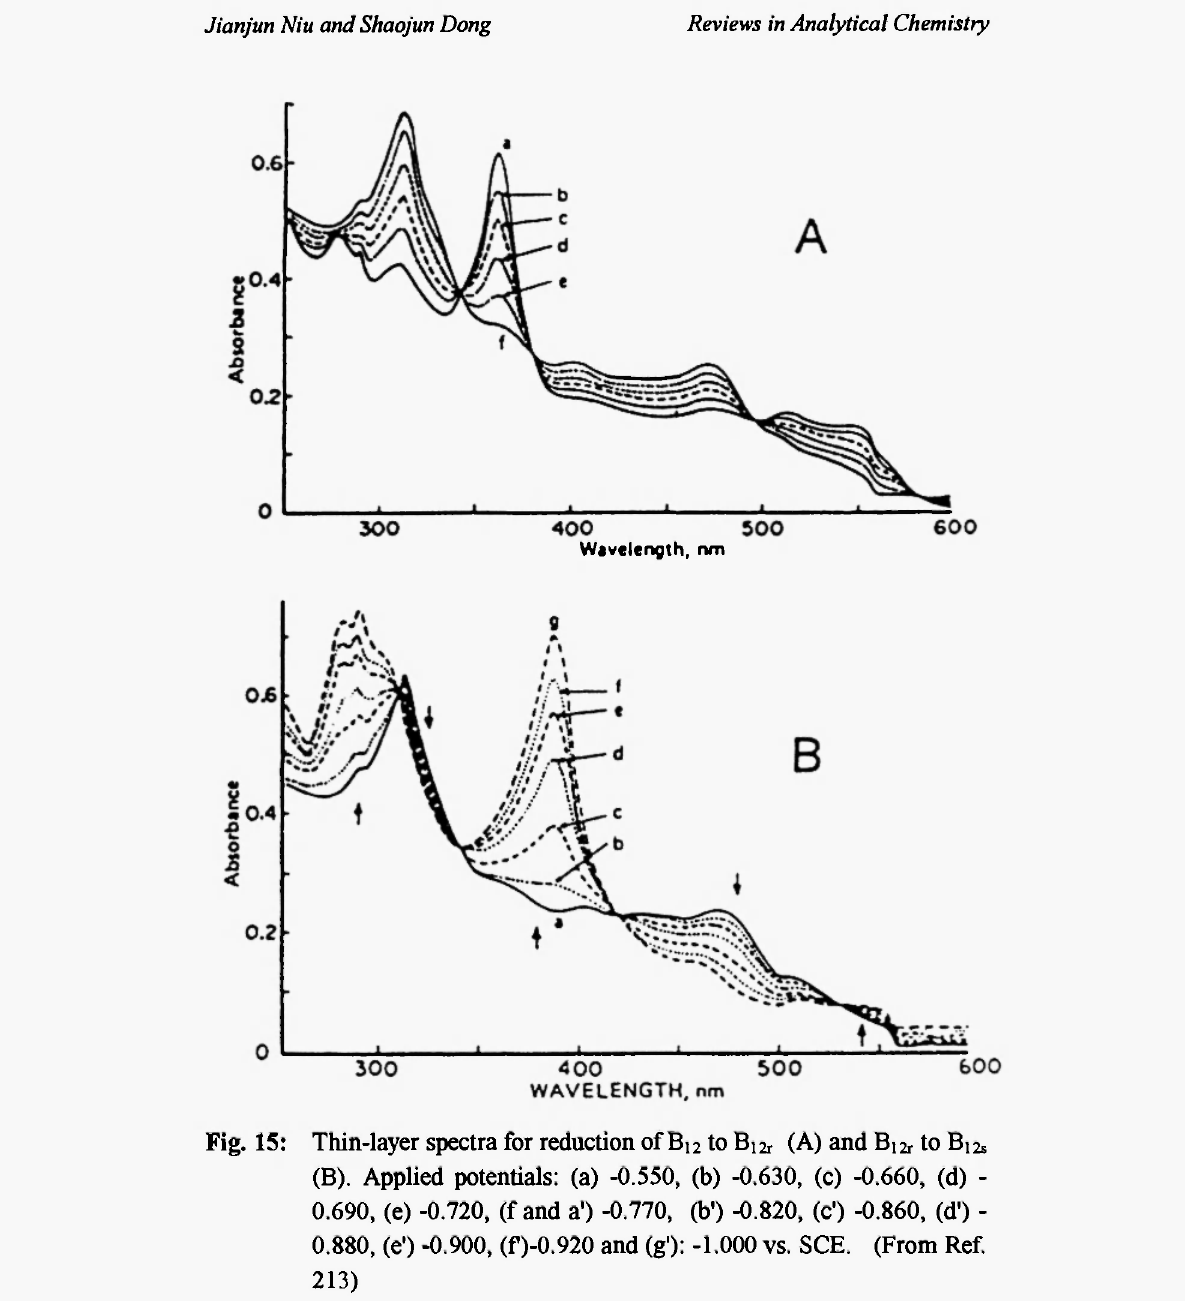
Fig. 15: Thin-layer spectra for reduction of B (B). Applied potentials: (a) -0.550, (b) -0.630, (c) -0.660, (d) - 0.690, (e) -0.720, (fand a') -0.770, (b') -0.820, (c') -0.860, (d')